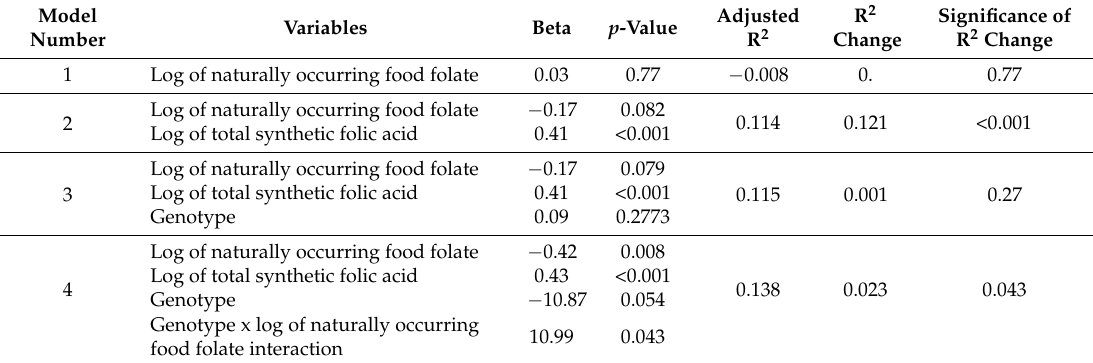
Table 5. Caucasian stratified predictors of RBC folate via hierarchical linear regression ( n = 123).